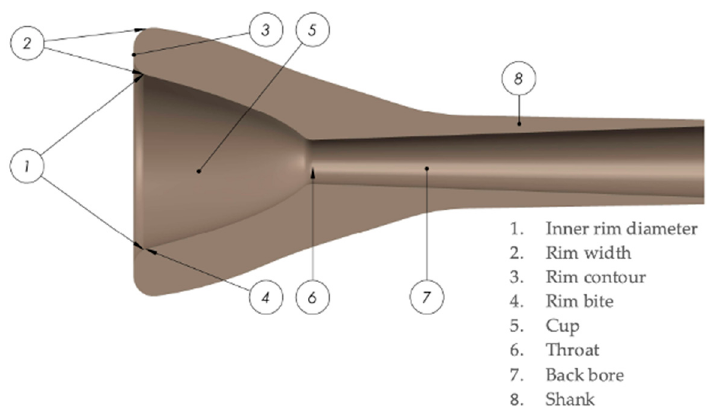
Figure 1. Parts of a trombone